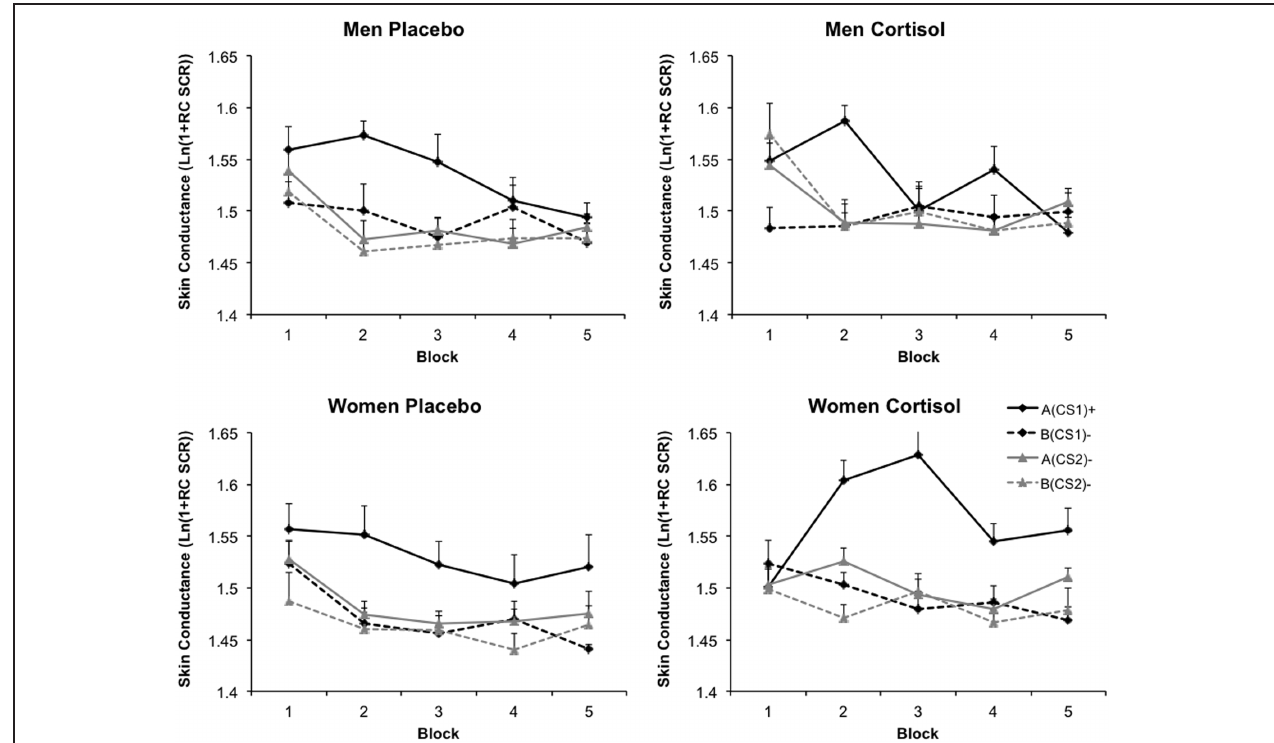
FIGURE 4 | Skin conductance responses. Skin conductance data were range corrected and subsequently log transformed. Blocks consist of averages of two trials of each CS type. Graphs depict data as a function of Sex and Drug. Error bars represent standard errors of the mean.